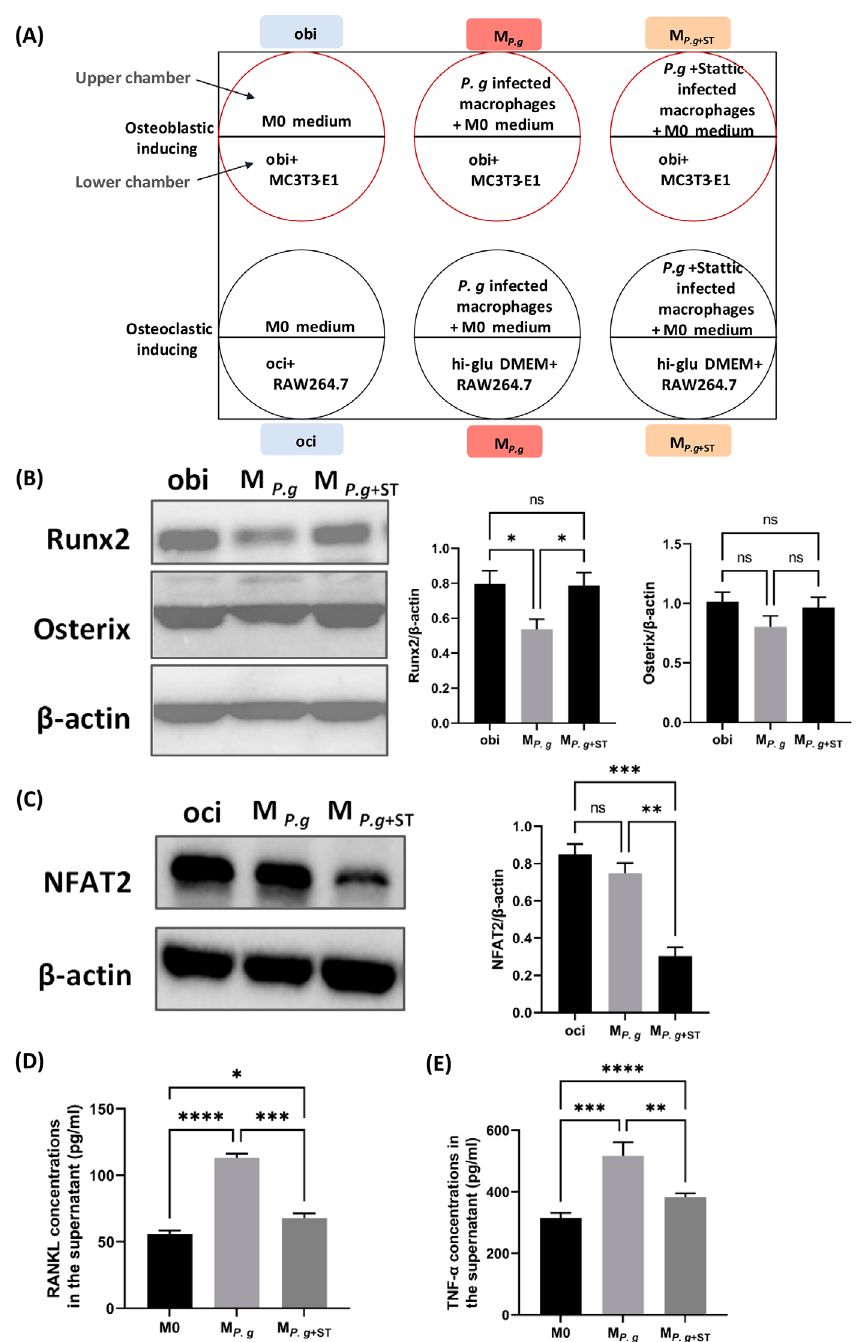
Figure 7- Effects of P. gingivalis -infected macrophages on protein expression levels in MC3T3-E1 and RAW264.7. (A), schematic diagram of the co-culture system. (B), representative bands and grayscale analysis for Runx2 and Osterix protein expression levels in MC3T3-E1 cells. (C), representative bands and grayscale analysis for NFAT2 protein expression levels in RAW264.7 cells. (D) and (E), TNF-α (D) and RANKL (E) production in BMDMs after P. gingivalis infection for 12 h with or without 5 μM Stattic. M0, unstimulated BMDMs; MP.g, BMDMs stimulated with P. gingivalis for 12 h; MP.g+ST, BMDMs stimulated with P. gingivalis in the presence of 5 μM Stattic for 12 h. obi, osteoblastic-induced medium; hi-glu DMEM, complete high-glucose DMEM medium; oci, osteoclastic-induced medium, composed of hi- glu DMEM supplemented with 50 ng mL-1 RANKL. *p<0.05; **p<0.01; ***p<0.001; ****p<0.0001; ns, not